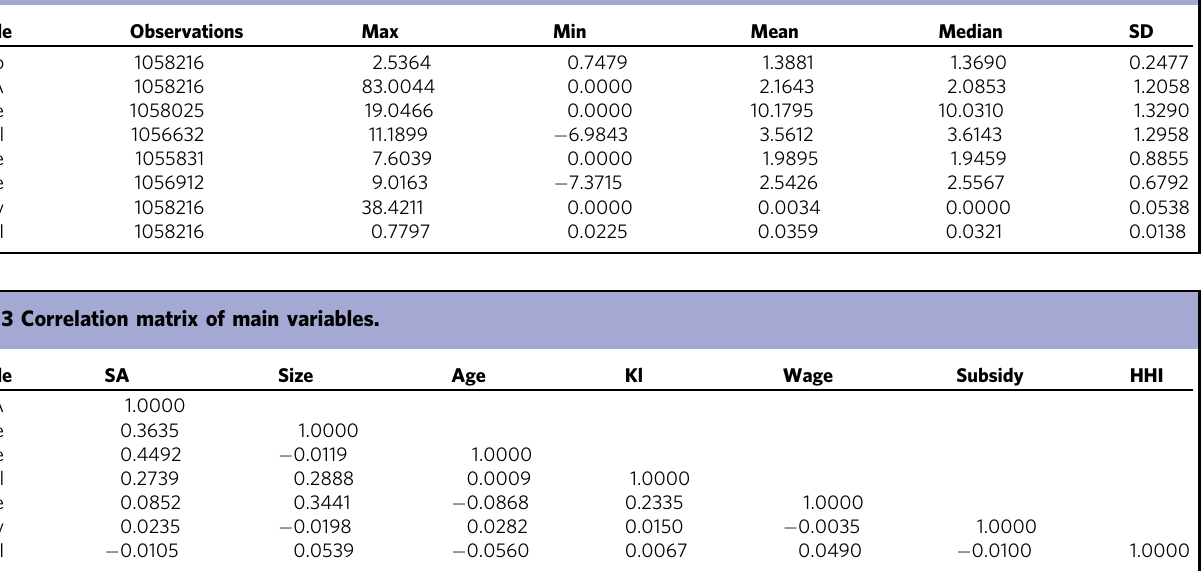
Table 2 Summary statistics.